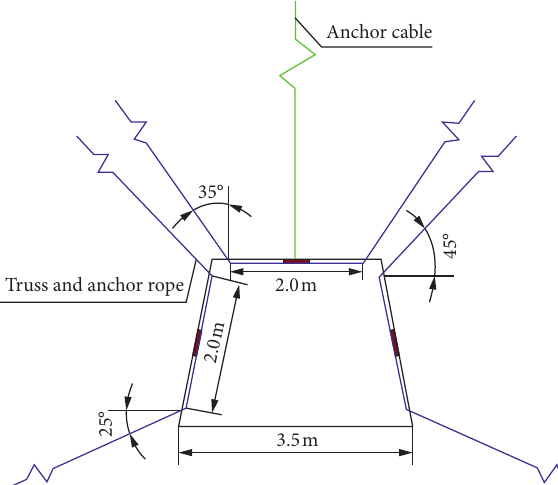
Figure 10: Cross section of anchor cable with the truss and anchor rope